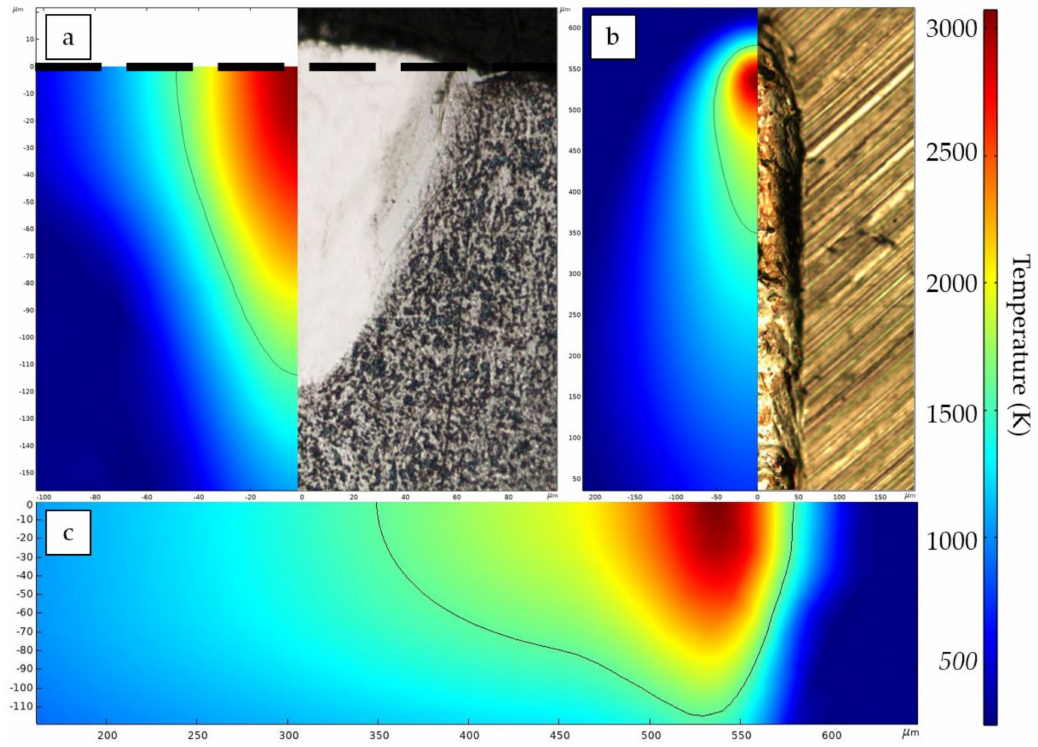
Figure 10. Calculated temperature field for the P = 100 W and V = 400 mm/s: ( a ) transverse cross-section at the center of the laser beam; ( b ) top view; ( c ) longitudinal cross-section. The solid line represents the fusion zone boundary.